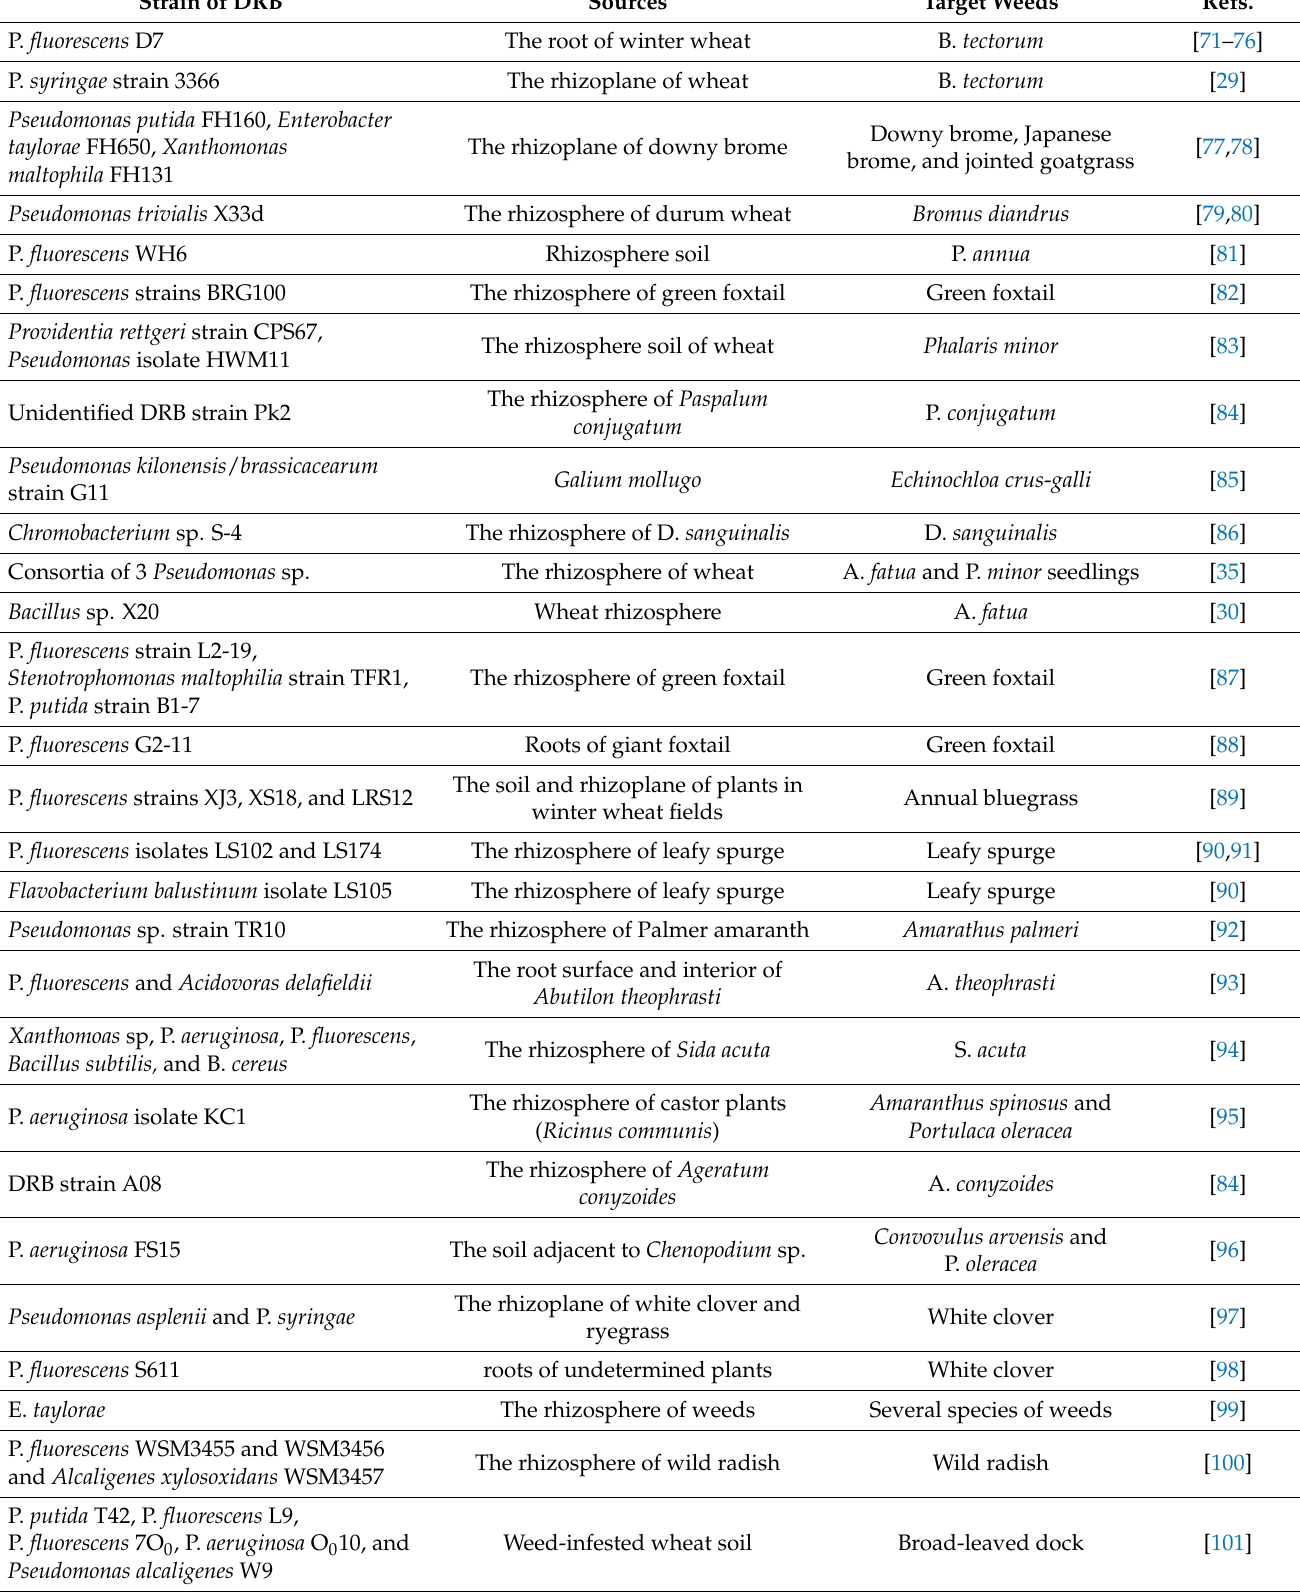
Table 2. Deleterious rhizobacteria (DRB) with herbicidal